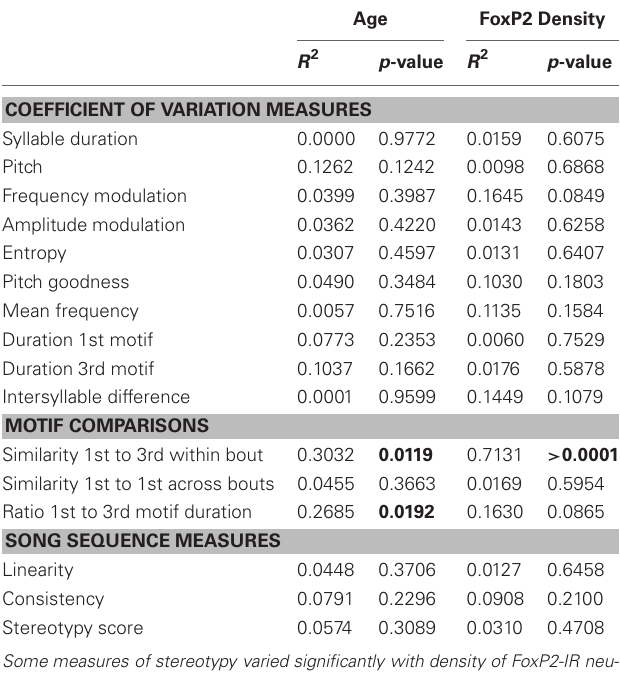
Table 1 | Statistical results comparing various measures of song stereotypy with age and intensely-stained FoxP2-IR neuron